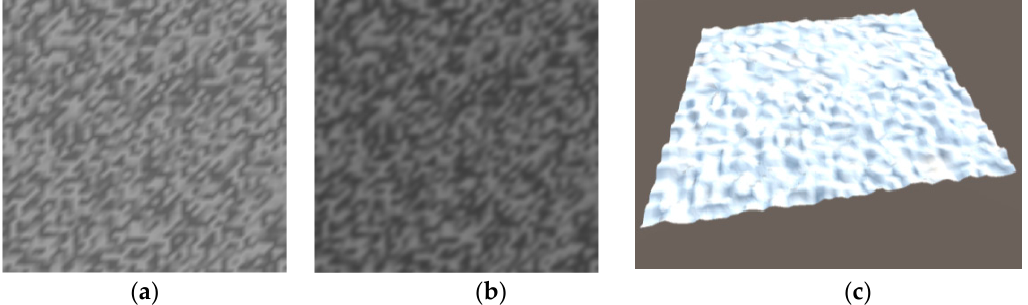
Figure 8. Using the script to create stochastic ground: ( a ) PNG image; ( b ) PNG image after Gauss blur; ( c ) stochastic ground after Gauss blur.